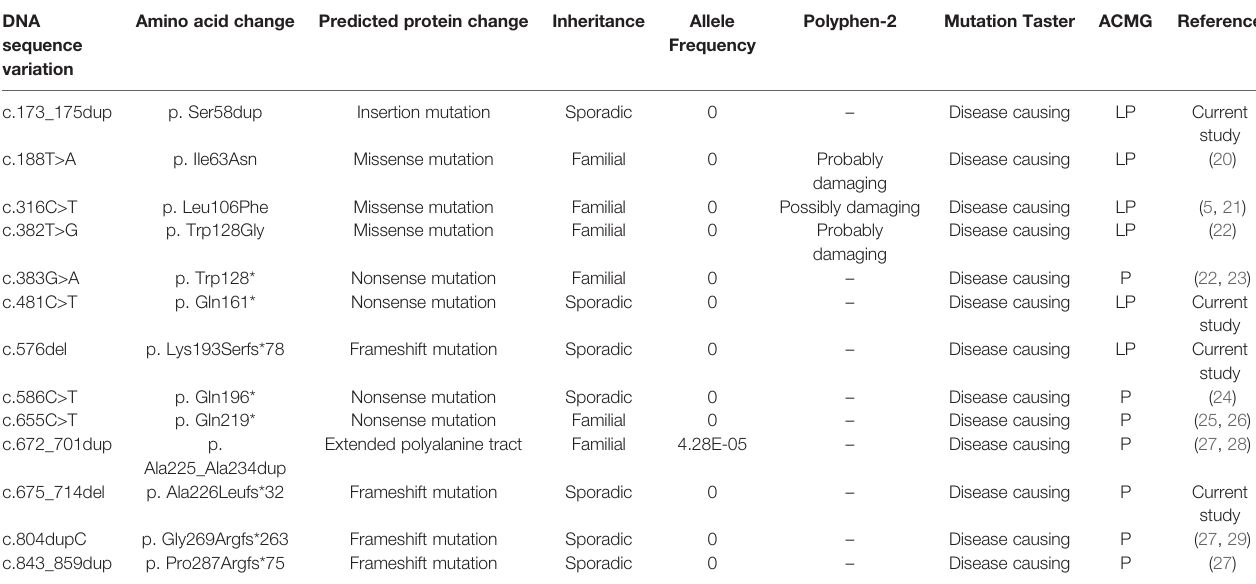
TABLE 1 | The FOXL2 mutations identi fi ed in the current